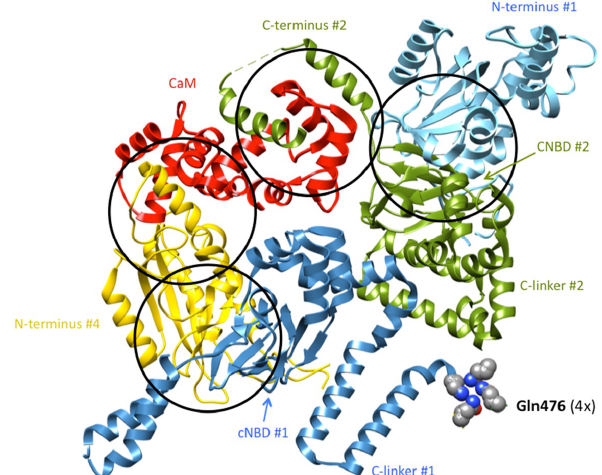
Figure 4. Intricate arrangement of cytoplasmic domains and CaM in Kv10.1 (eag1) channels (PDB: 5K7L). Three out of the four subunits of the channel establish contacts. The C-terminus of subunit #1 (blue) interacts with the N-terminus of subunit #4 (yelow). CaM (red) interacts with the N-terminus of subunit #4, and with the C-terminus of subunit #2 (green). The C-terminus of this subunit is also in close proximity to the N-terminus of subunit #1, resulting in bridging three out of the four subunits. This complex network of interactions is repeated four-fold in the full channel. The transmembrane segments and N- or C-terminal domains not implicated in these interactions have been removed for clarity. Atoms corresponding to residues Q476 at which the cytoplasmic gate is located are shown as spheres.